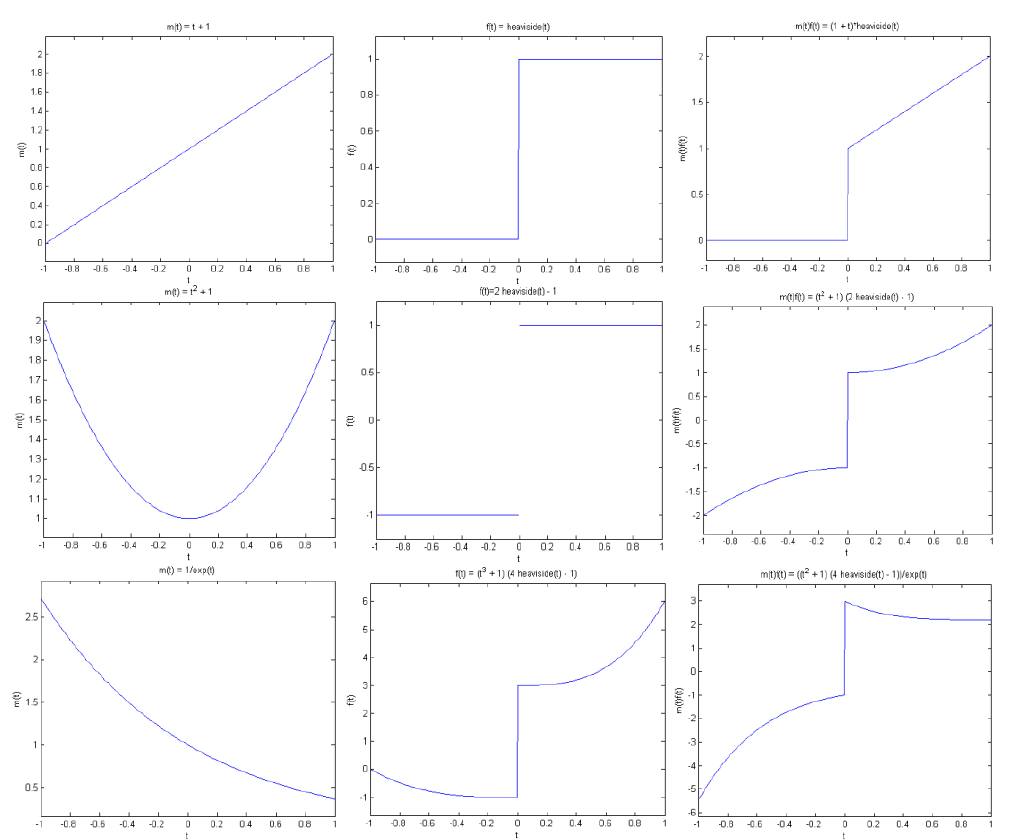
Figure 4. ( Left )—Modulation function m ( t ); ( Middle )—Signal f ( t ); ( Right )—Modulated signal m ( t ) f ( t